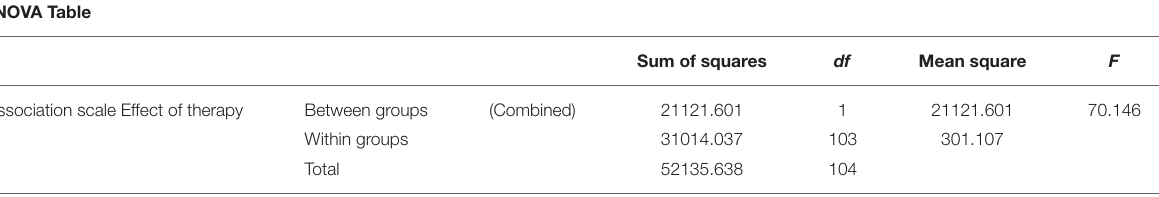
TABLE 4 | The variance analysis of the results of the two groups of patients. ANOVA